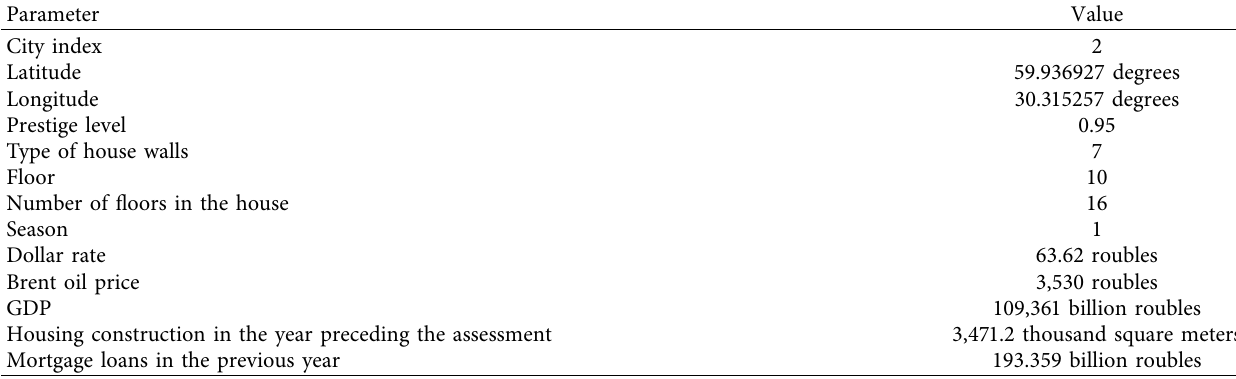
Table 3: Input parameters of the model that characterize a house in Saint Petersburg, its geographical location, evaluation time, and the corresponding economic situation in the world, country, and